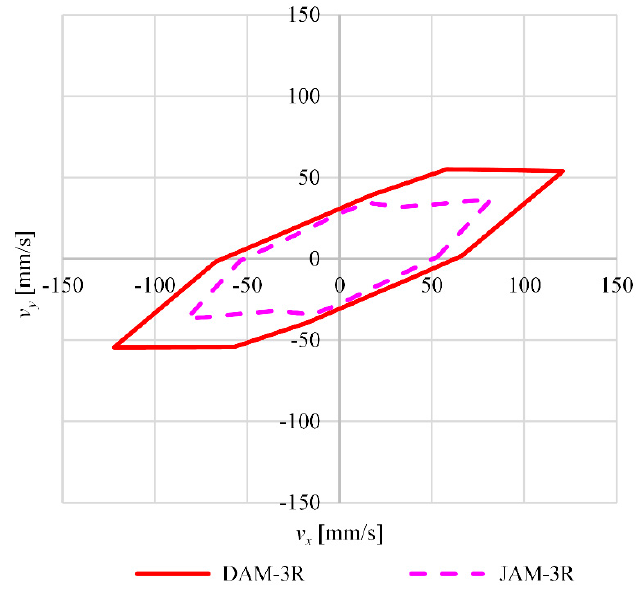
Figure 5. The maximum end-effector velocity evaluated for the DAM-3R (red solid line) and JAM-3R (magenta dotted line) at the end-effector position (200 mm, − 150 mm).